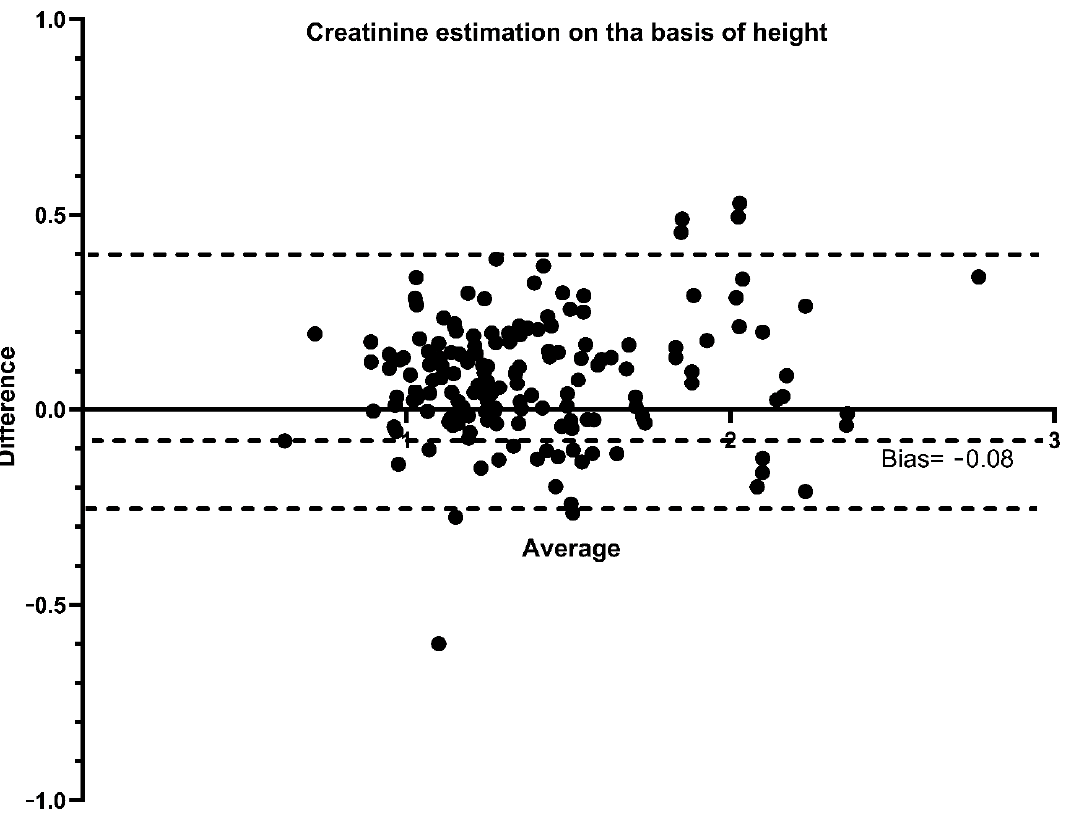
Figure 3. Bland–Altman plots comparing the HC/BC calculated on the basis of the measured baseline creatinine and on the basis of the height-estimated baseline creatinine. Dashed lines represent the limits of agreement and mean difference (bias) in estimations. Finally, we compared the AUROC of HC/BC ratio calculated on the basis of ebSCr with AUROC of the HC/BC ratio calculated on the basis of mbSCr (gold standard). As expected, the gold standard (HC/BC ratio calculated on the basis of mbSCr) had an AUROC = 1.00 with a 95% confidence interval (CI) between 0.98 and 1.00, p < 0.001 (Figure 4, blue line). The HC/BC ratio calculated on the basis of ebSCr also had significant AUROC (AUROC = 0.94; 95% CI: 0.90–0.97; p < 0.001) (Figure 4, dotted line). The comparison of the two ROC curves showed a p < 0.001.